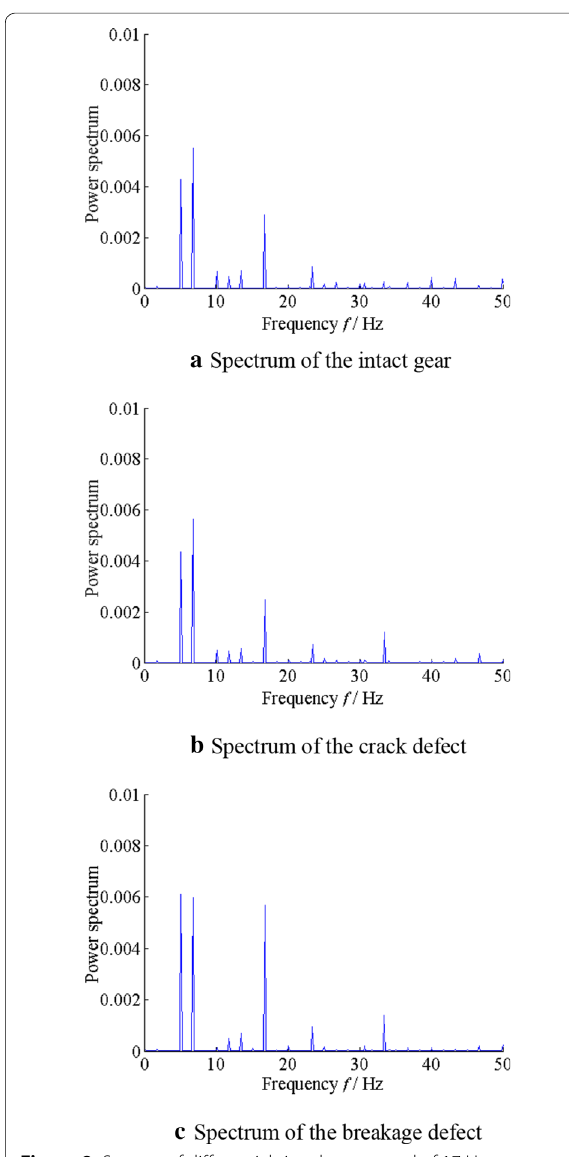
Figure 8 Spectra of differential signals at a speed of 17 Hz